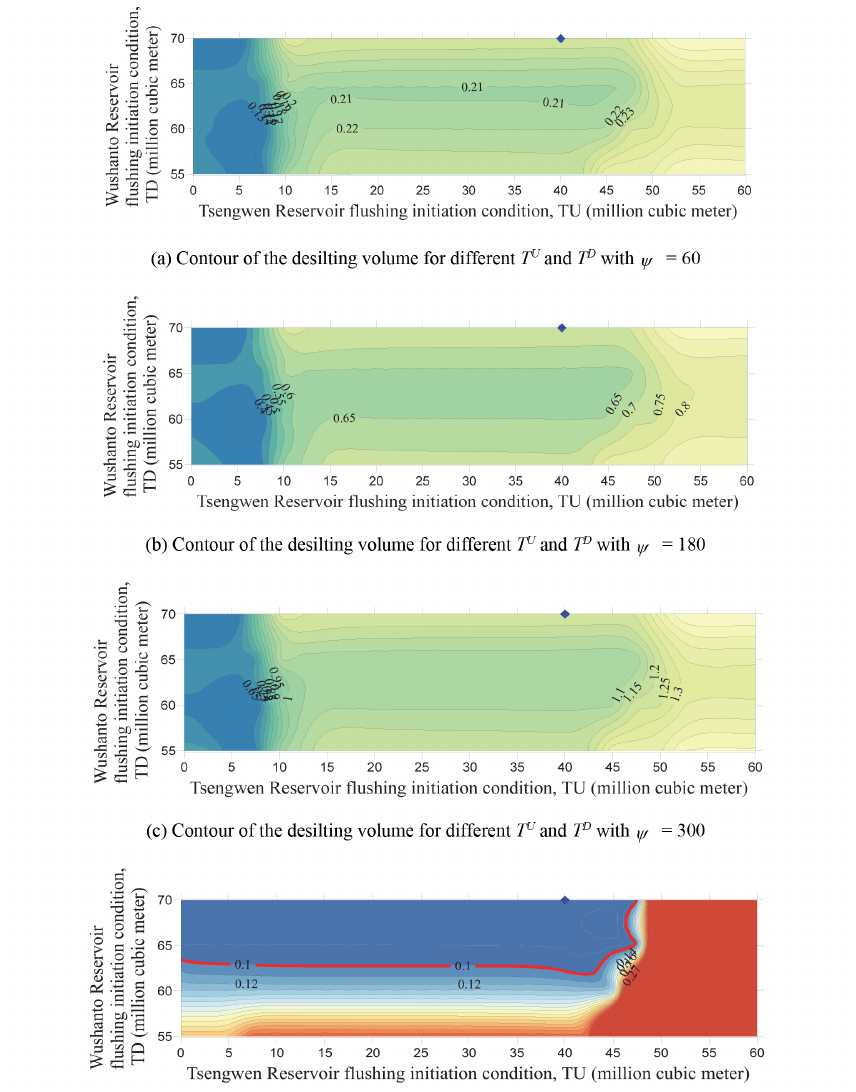
Figure A3. Results of sensitivity analysis of flushing coefficient and threshold storage for the 15th